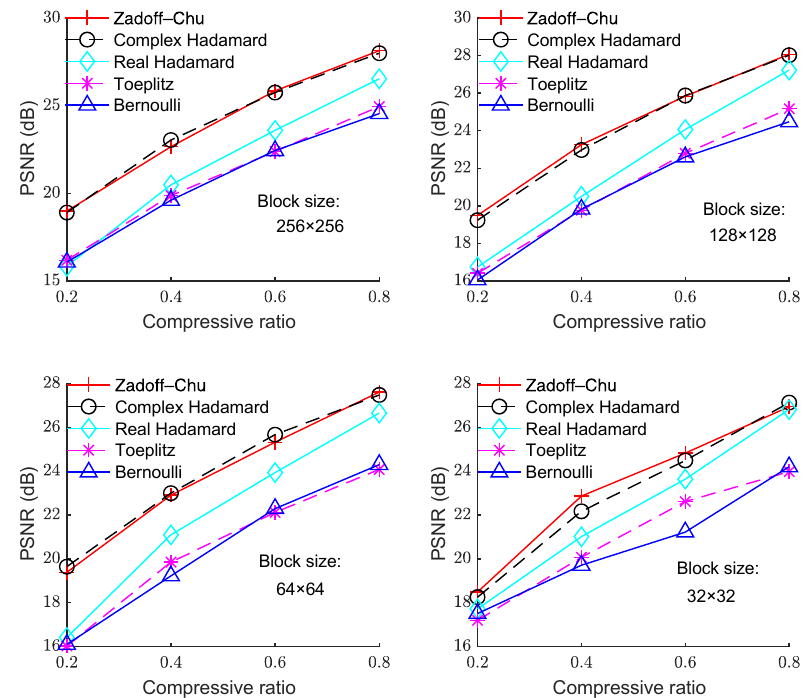
Figure 2. PSNR with CR under different block sizes for the “Cameraman” image.